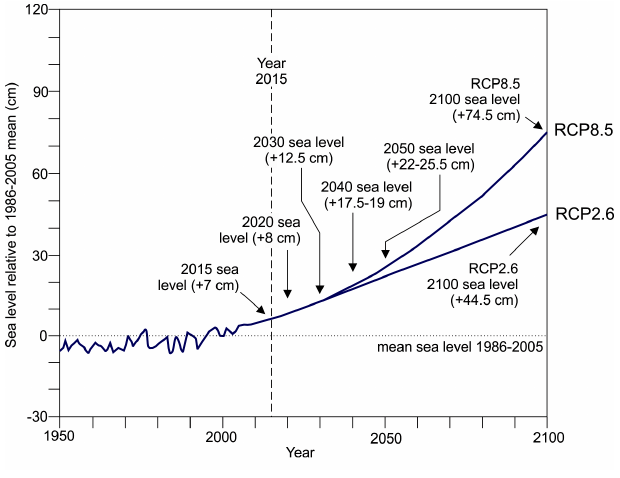
Fig. 3 . Past and projected sea-level change in Fiji (1950-2100; after BOM 2014). Projections are based on high and low representative concentration pathways (RCPs); uncertainty ranges are not